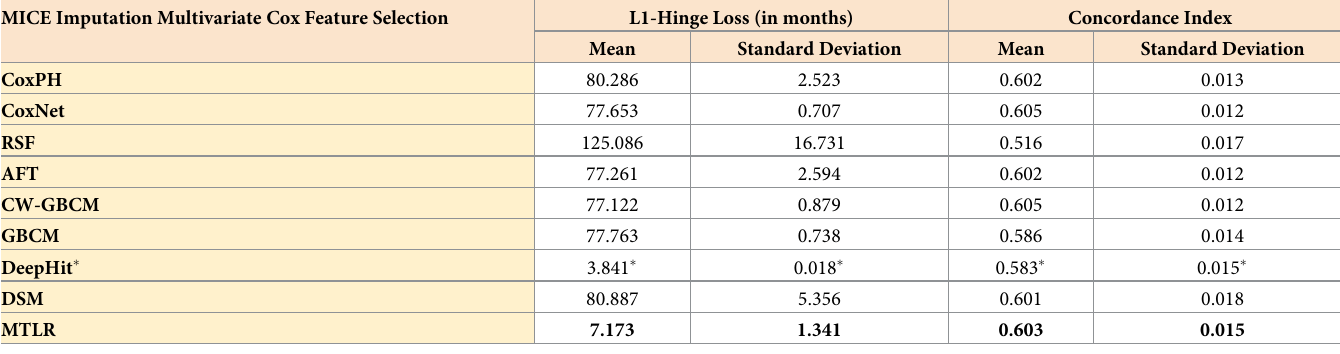
Table 2. Comparison of all ISD algorithms using MICE imputation and multivariate Cox feature selection. MICE Imputation Multivariate Cox Feature